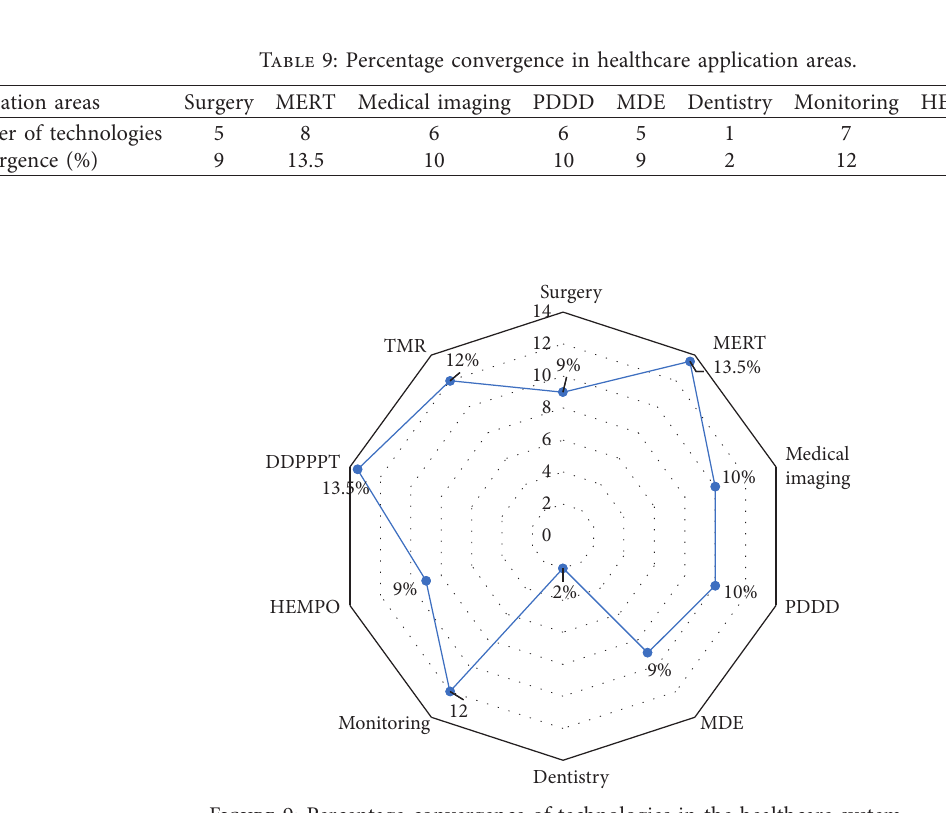
Figure 9: Percentage convergence of technologies in the healthcare